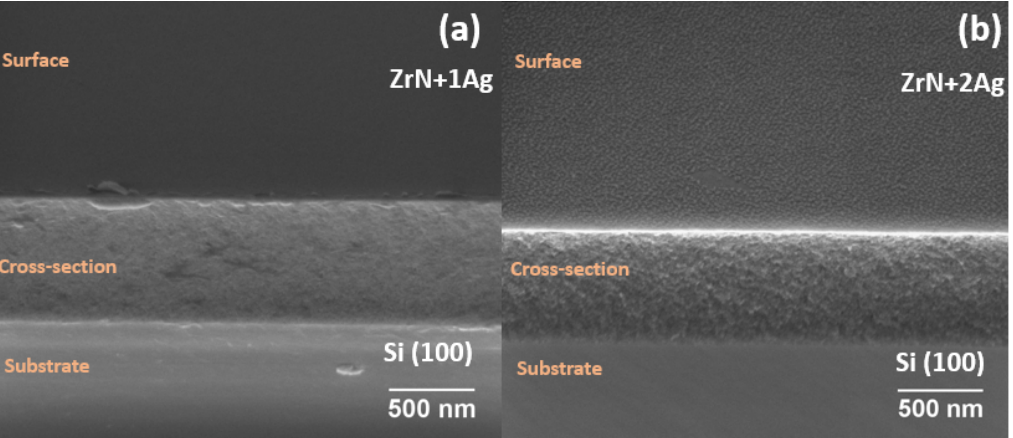
Figure 4. Surface and cross-sectional SEM images of ( a ) ZrN+1Ag and ( b ) ZrN+2Ag coatings. In order to determine the homogeneity of the coatings, elemental mapping was car- ried out using EDS on the surface of the ZrN and ZrN+2Ag coatings. Figure 5 shows the concentration of the elements deposited (Zr, N, and Ag) for the samples. The coatings show a homogeneous distribution of zirconium and nitrogen throughout the surface, as expected. In addition, with the Ag incorporation, the EDS mapping shows that metallic silver exhibits homogeneous distribution on the surface, which is in accordance with the SEM results.